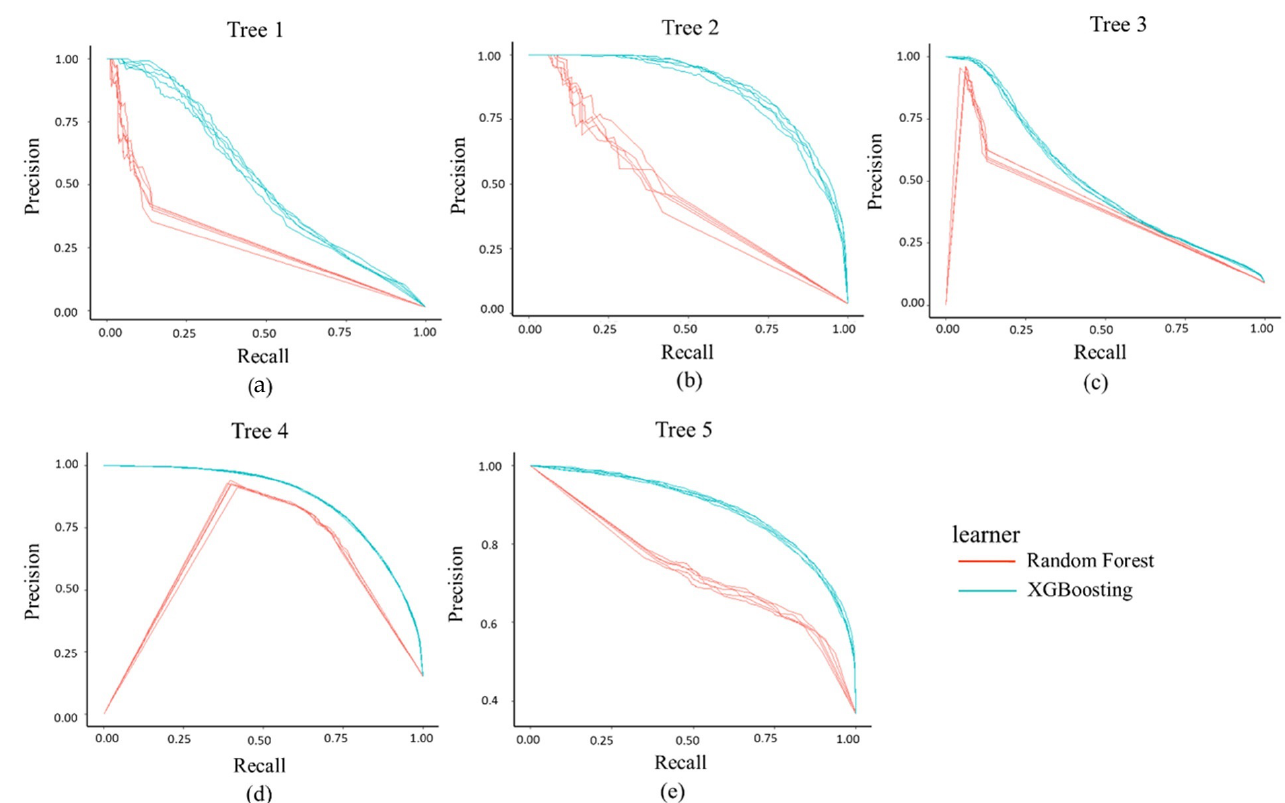
Figure 5. Precision–Recall areas of each evaluated tree based on Random Forest and XGBoosting algorithms. The red and blue colors indicate Random Forest and the XGBoosting model, respectively. The area under the Precision–Recall curve means the performance of the classifier.